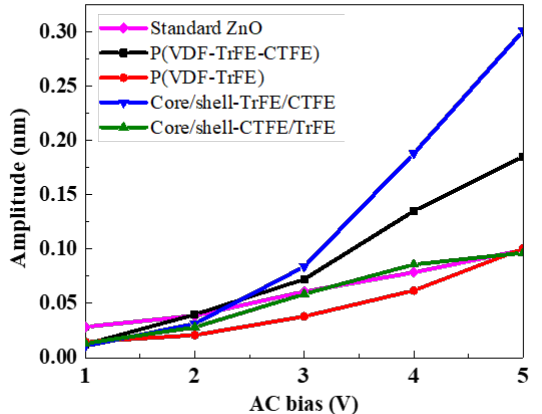
Figure 8. Piezoelectric signal versus the applied AC voltage in the single and coaxial electrospun nanofibers.